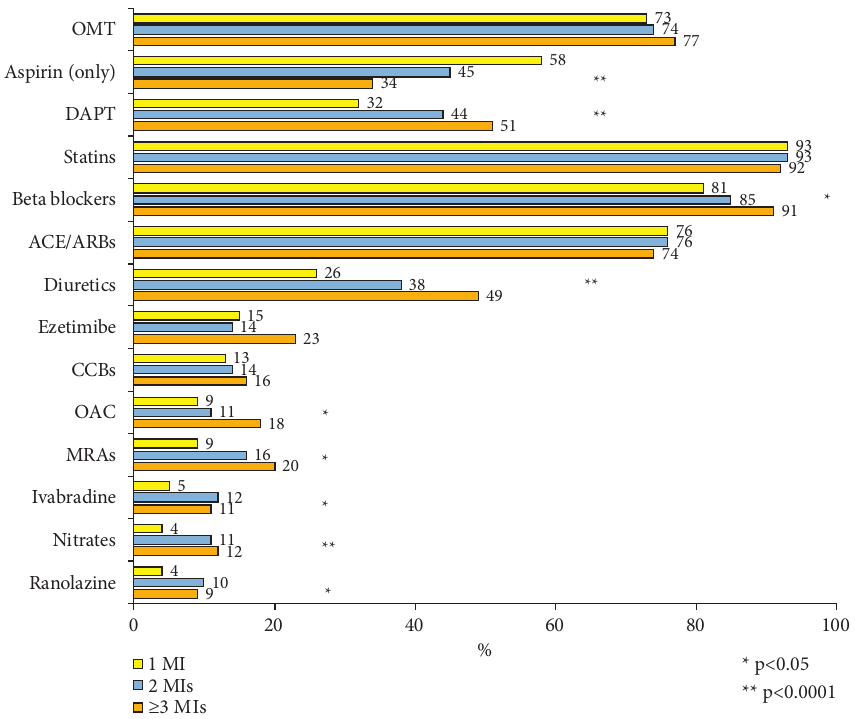
Figure 3: Cardiovascular therapies prescribed at enrolment in the 3